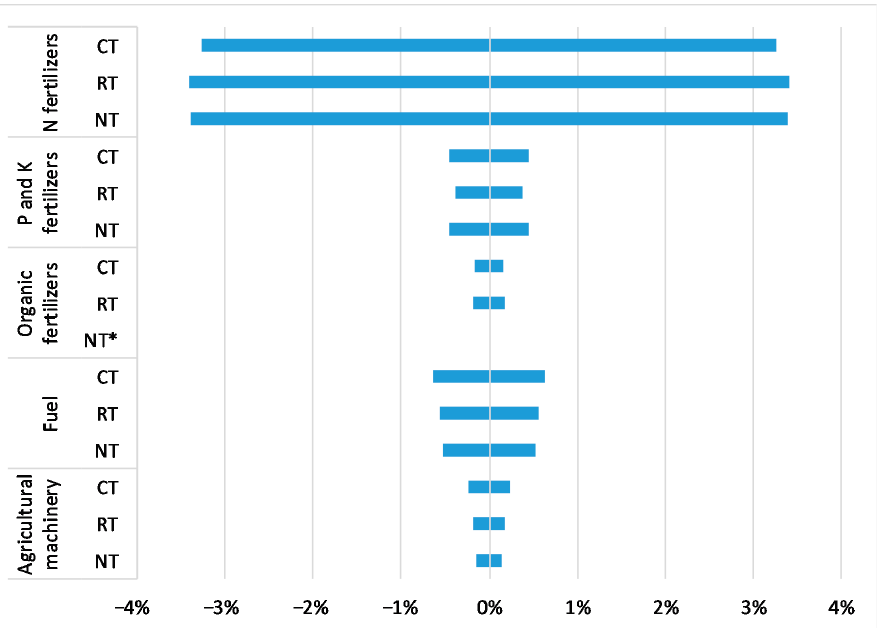
Figure 7. The sensitivity analysis of input parameters for the carbon footprint of the grain maize production in conventional tillage (CT), reduced tillage (RT), and no-tillage (NT). * Without application of organic fertilizers.